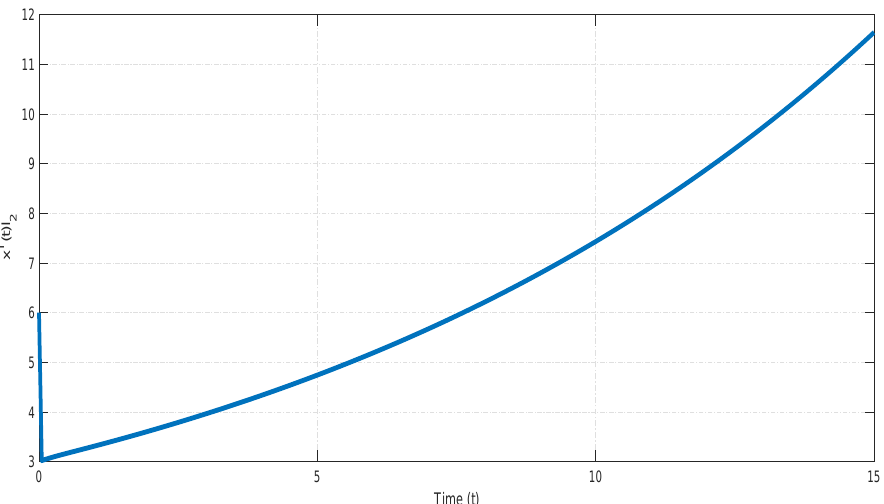
Figure 5. The value of x T ( t ) l 2 of the second subsystem in Example